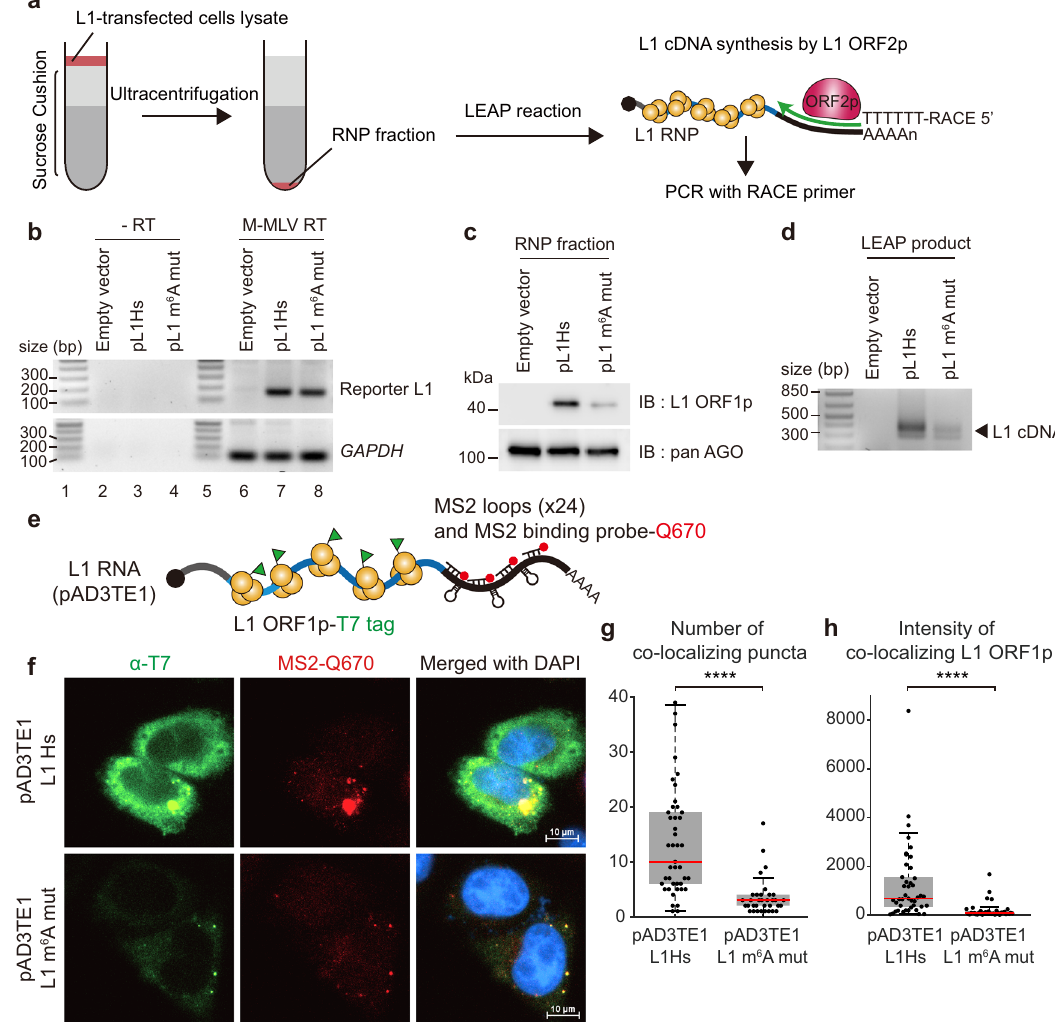
Fig. 5 m 6 A modi fi cation is crucial for generating retrotransposition-competent L1 RNPs. a Scheme of LEAP assay with description. Ultracentrifugation and puri fi cation cellular RNP (left part of scheme, cell lysate in red, and sucrose cushion in gray). LEAP reaction (right part of scheme, L1 ORF1p in yellow, L1 ORF2p in magenta, 3 ′ RACE adapter in green). b Quanti fi cation of mRNA levels in the RNP fraction of pL1-expressing HeLa cells. cDNA synthesis in the absence of reverse transcriptase (lane 2 – 4) and transfection of empty vector (lane 6) served as negative controls. The RT-PCR products of reporter L1 and GAPDH are of 158 and 106 bp, respectively (lane 6 – 8). Lane 1 and 5 show the DNA ladder. c Immunoblot assay of the RNP fraction from pL1-expressing HeLa cells. pan AGO served as a loading control. d LEAP assay using RNP fraction from pL1-expressing HeLa cells. The LEAP product is a diffuse band of 300 – 400 bp. The images of b – d are representative of three independent experiments. e A schematic of the L1-MS2 construct (pAD3TE1) carrying T7- tagged ORF1p (green) and MS2-stem-loops with Q670-labeled MS2 binding probes (red). f Immuno fl uorescence and RNA FISH images depicting HeLa cells transfected with pAD3TE1 L1Hs (top) or L1 m 6 A mut (bottom). Images for T7-tagged ORF1p (green), L1-MS2 RNA (red), and the merged images with DAPI (blue) are indicated. The images are representative of two independent experiments. g The number of L1 RNP foci in pAD3TE1-expressing HeLa cells. Colocalizing puncta within an intermolecular distance of 330 nm were counted as L1 RNP using z-stack analysis. h Intensity of L1 ORF1p in colocalizing puncta. Each point represents the intensity of L1 ORF1p per cell. g , h Boxplots indicate median (red middle line), 25th, 75th percentile (gray box) and 5th and 95th percentile (whiskers). 43 cells for L1Hs and 34 cells for L1 m 6 A mut, two-sided Kolmogorov – Smirnov test, **** p < 0.0001. Source data are provided as a Source data fi